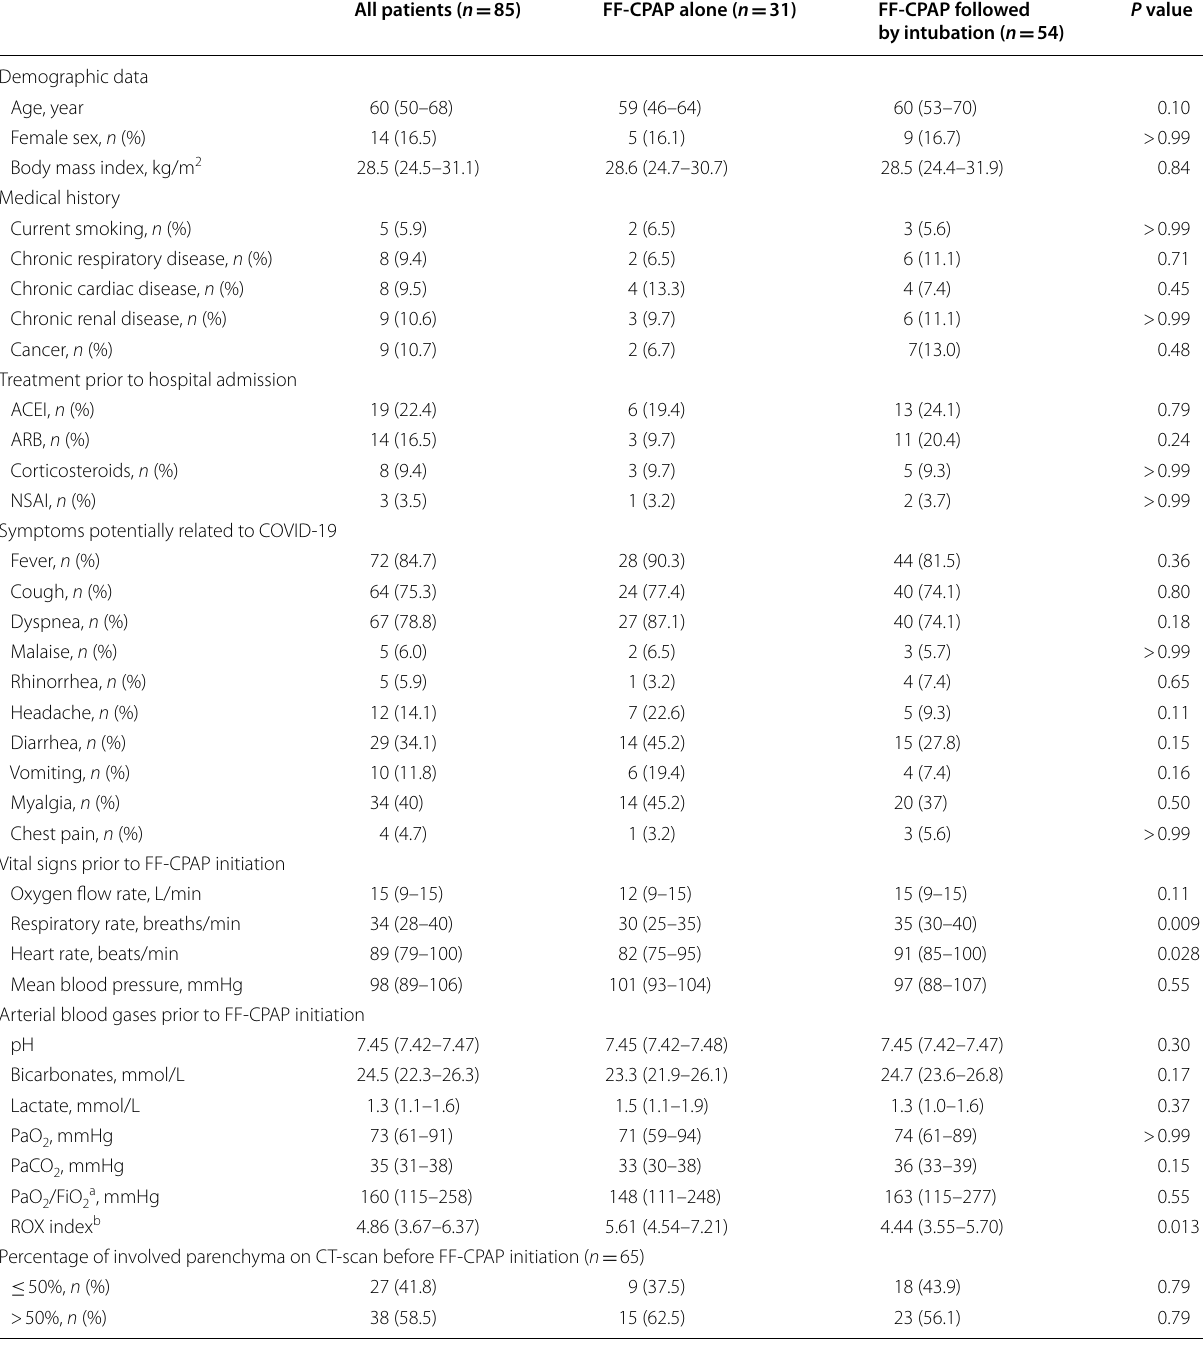
Table 2 Baseline characteristics of patients on